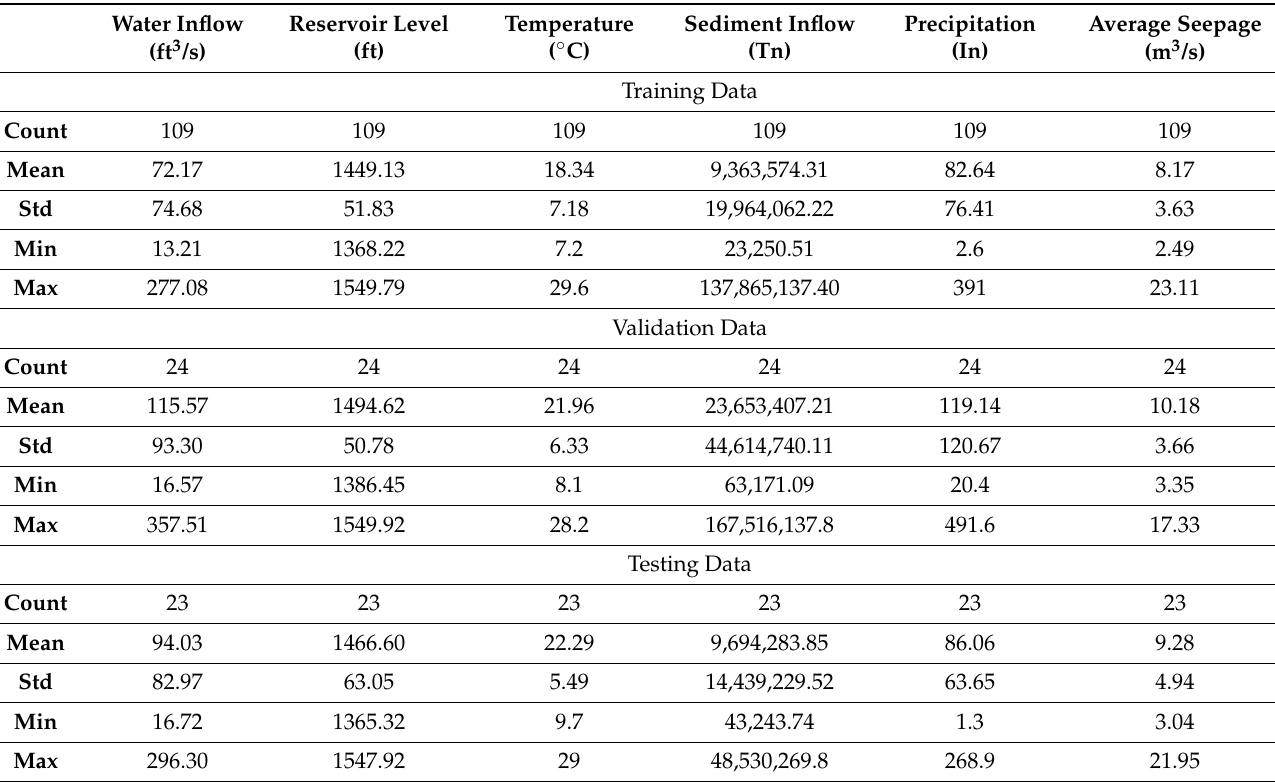
Table 3. Descriptive statistic of parameters used for dam seepage